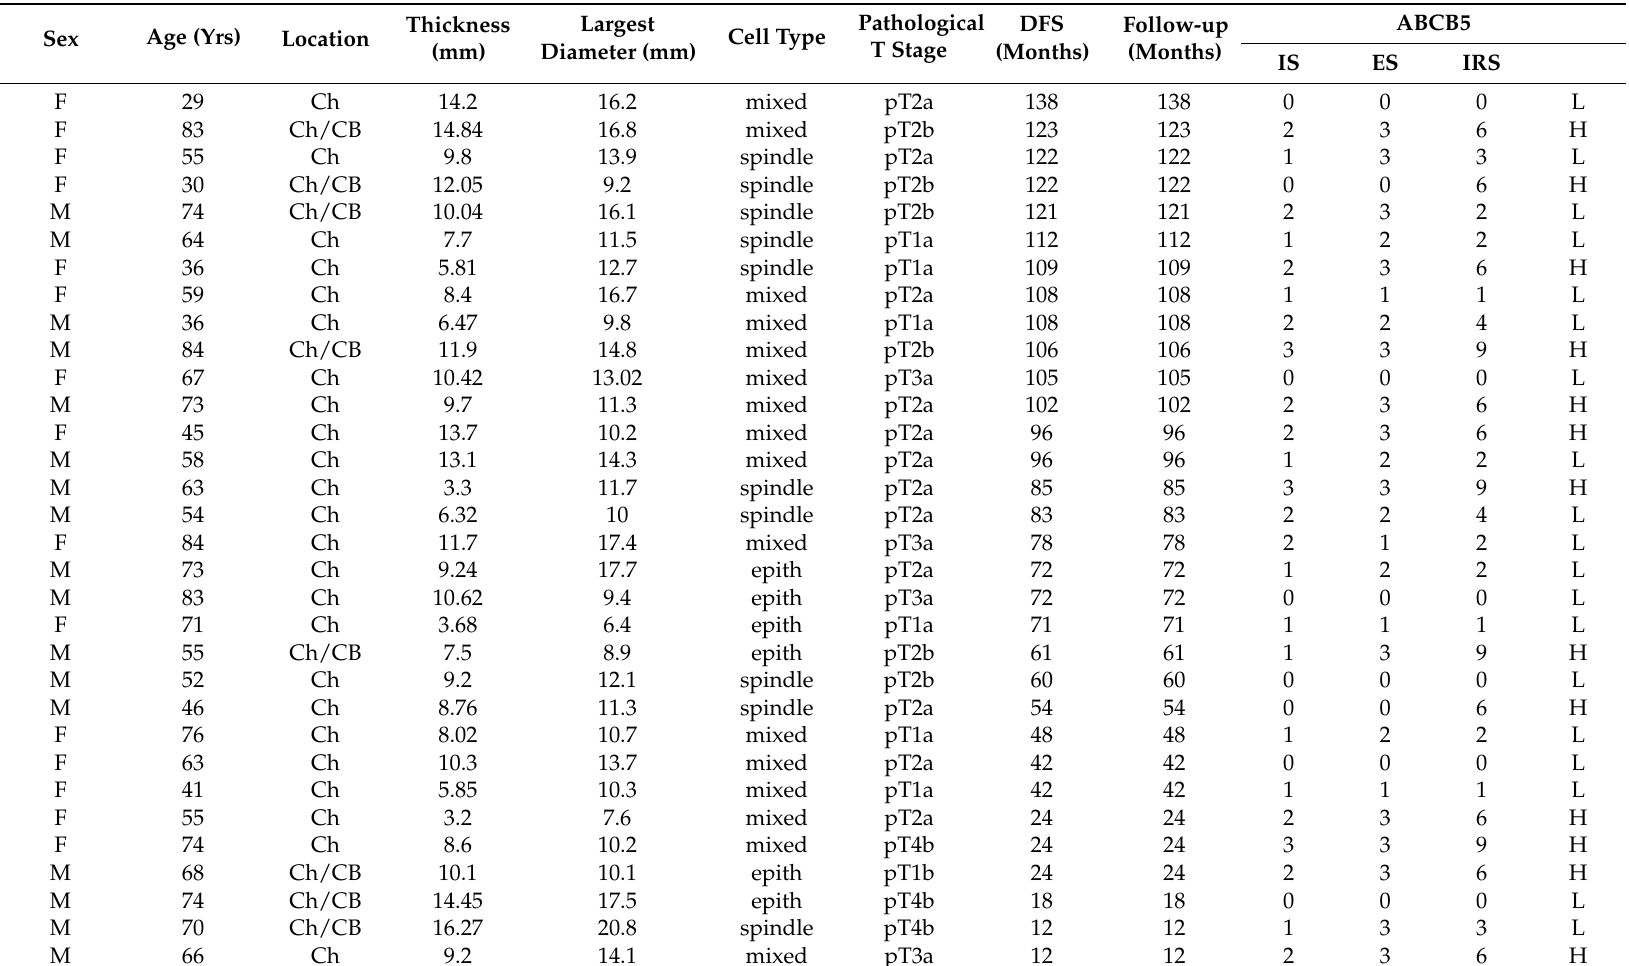
Table 1. Demographics, tumor parameters, disease free time, follow-up and ABCB5 expression in primary uveal melanoma without metastasis ( n =